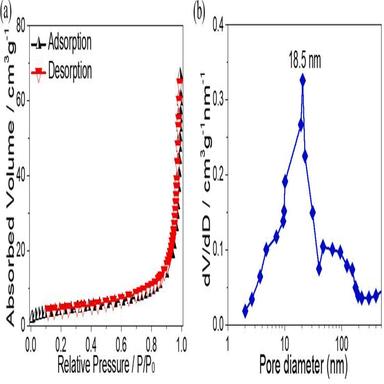
(a) N2 adsorption and desorption isotherms and (d) BJH pore size distribution.